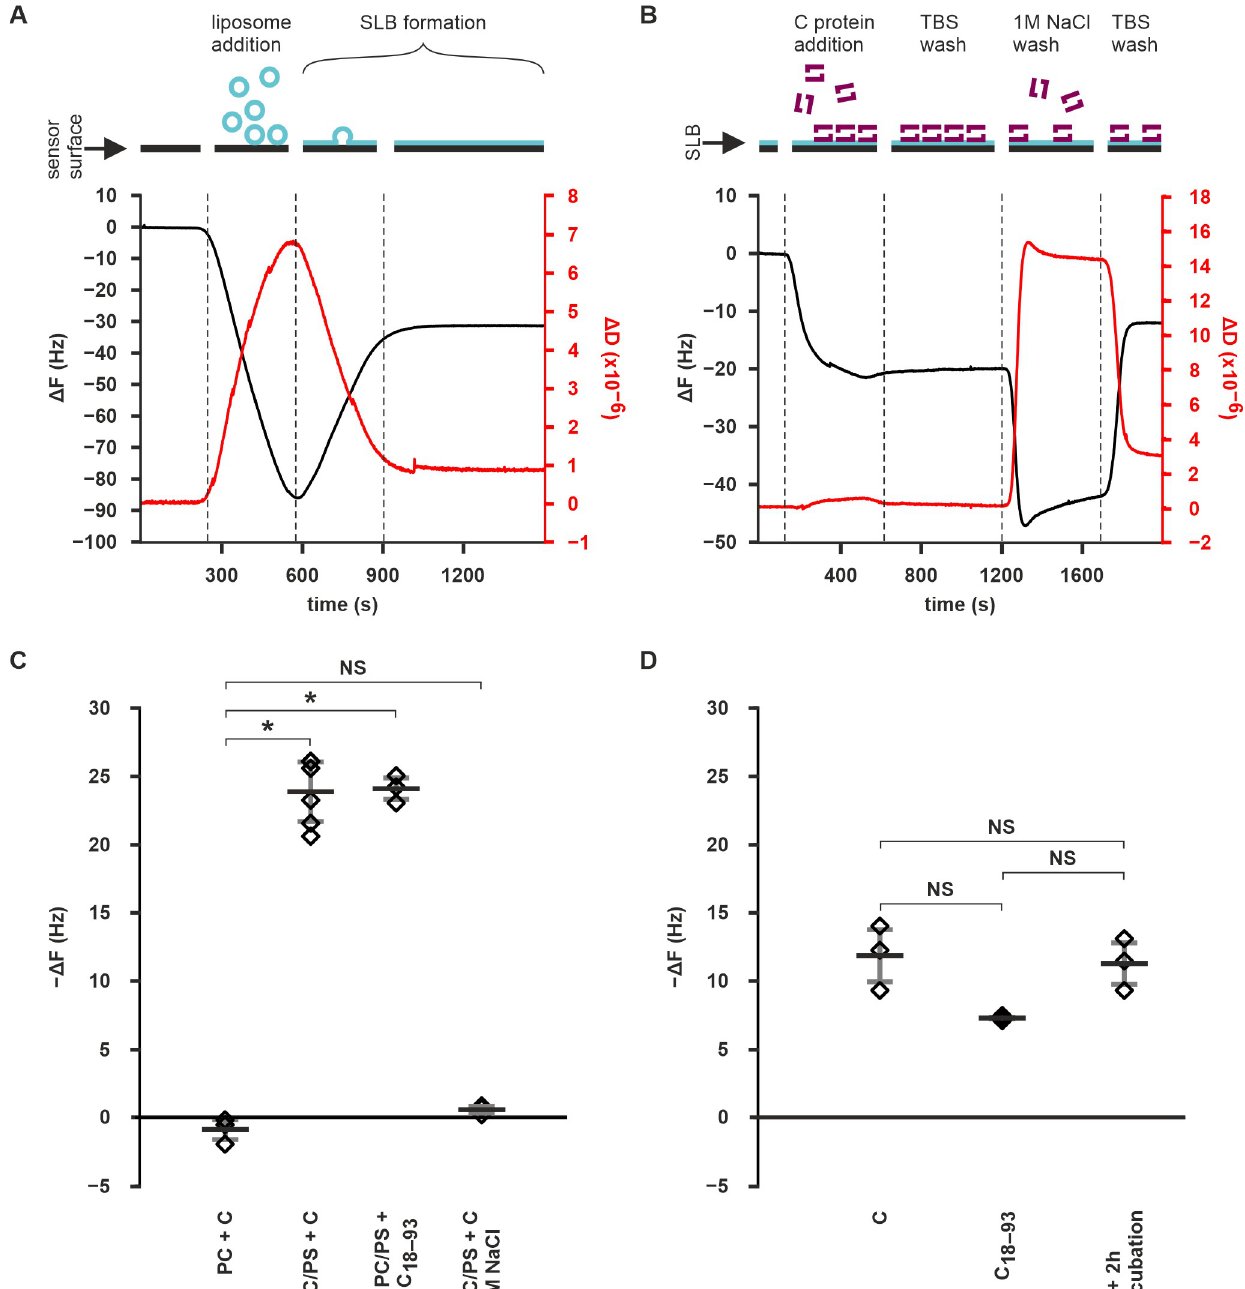
Fig 2. C protein binds to SLBs with negatively-charged lipids in QCM-D measurements. A Representative QCM-D curves from POPC/POPS SLB generation. The Δ F and Δ D have been zeroed to prelipid injection equilibrium values. B Representative QCM-D curves from a C protein binding experiment on POPC/POPS SLB. The Δ F and Δ D have been zeroed to equilibrium values after SLB formation. The large reversible changes in Δ F and Δ D after 1 M NaCl injection indicate a typical “buffer shift”, as the Δ F and Δ D values are sensitive to buffer viscosity [60]. C Quantitation of the final − Δ F values upon C protein and C 18–93 injection on SLBs composed of pure POPC (PC), or POPC/POPS mixture (PC/PS) either in TBS or in 1 M NaCl-containing buffer. D Quantitation of the final − Δ F values on SLBs with prebound C or C 18–93 after 1 M NaCl wash either right after equilibration, or after 2h incubation. Data information. Data in C and D are shown as the mean of 6 (C binding in TBS on POPC/POPS) or 3 (all others) replicates with the s.d. represented by the error bars. Individual measurements are shown as diamonds. Statistical significance (p < 0.05) is indicated by an asterisk and non- significant differences with NS. See main text for the